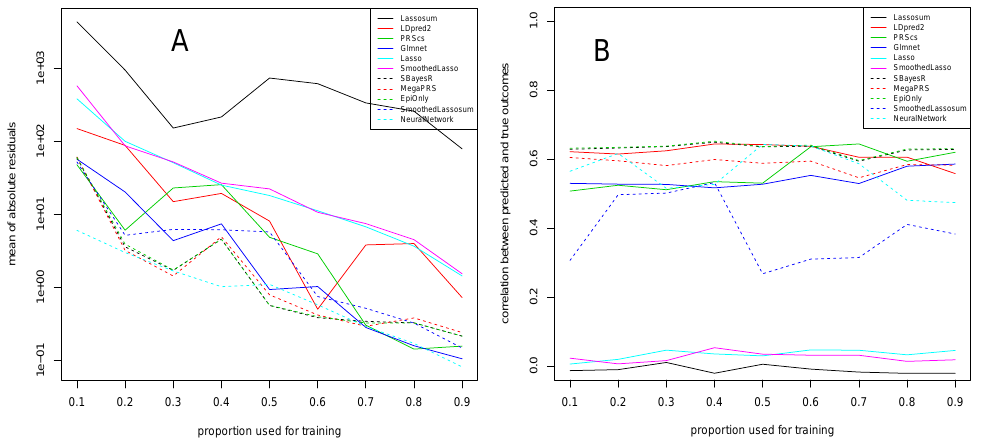
Figure 3. Dataset of the COPD study of [15]. Mean of absolute residuals ( A ) and correlation between predicted and true outcomes ( B ) as a function of the proportion of data used for